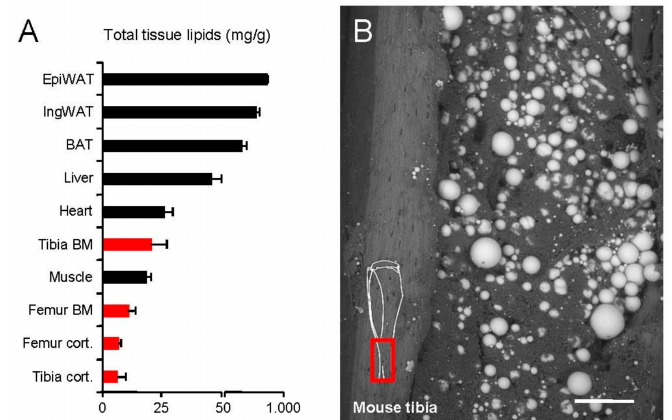
Figure 1. The skeleton is an adipose organ: ( A ) Total lipid content in metabolically active tissues (highlighted in black) and parts of the skeleton (highlighted in red) from 12-week-old female C57BL6/J mice. Mean ± SEM, n = 5; ( B ) Environmental scanning electron microscopy of a distal tibial specimen from 12-week-old female C57BL6/J mice revealing both cortical bone as well as adipocyte-containing bone marrow (red box indicates area in the tibia, scale bar: 0.1 mm).